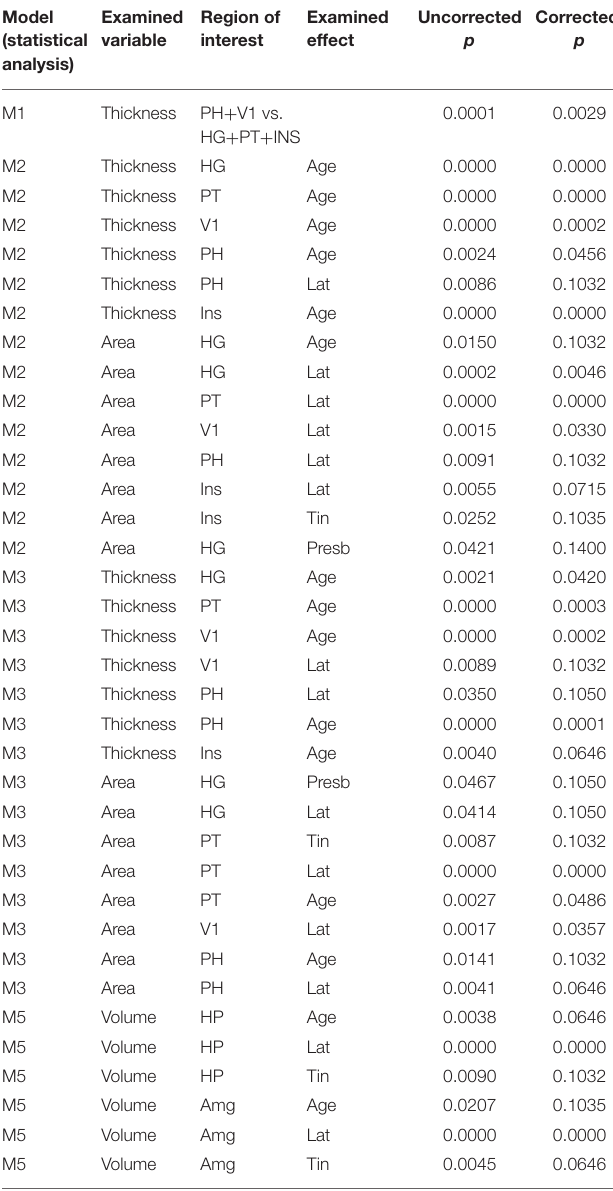
TABLE 1 | Statistical significance of examined effects shown as uncorrected p and corrected p (after correction for multiple comparisons by Holm method). Model (statistical